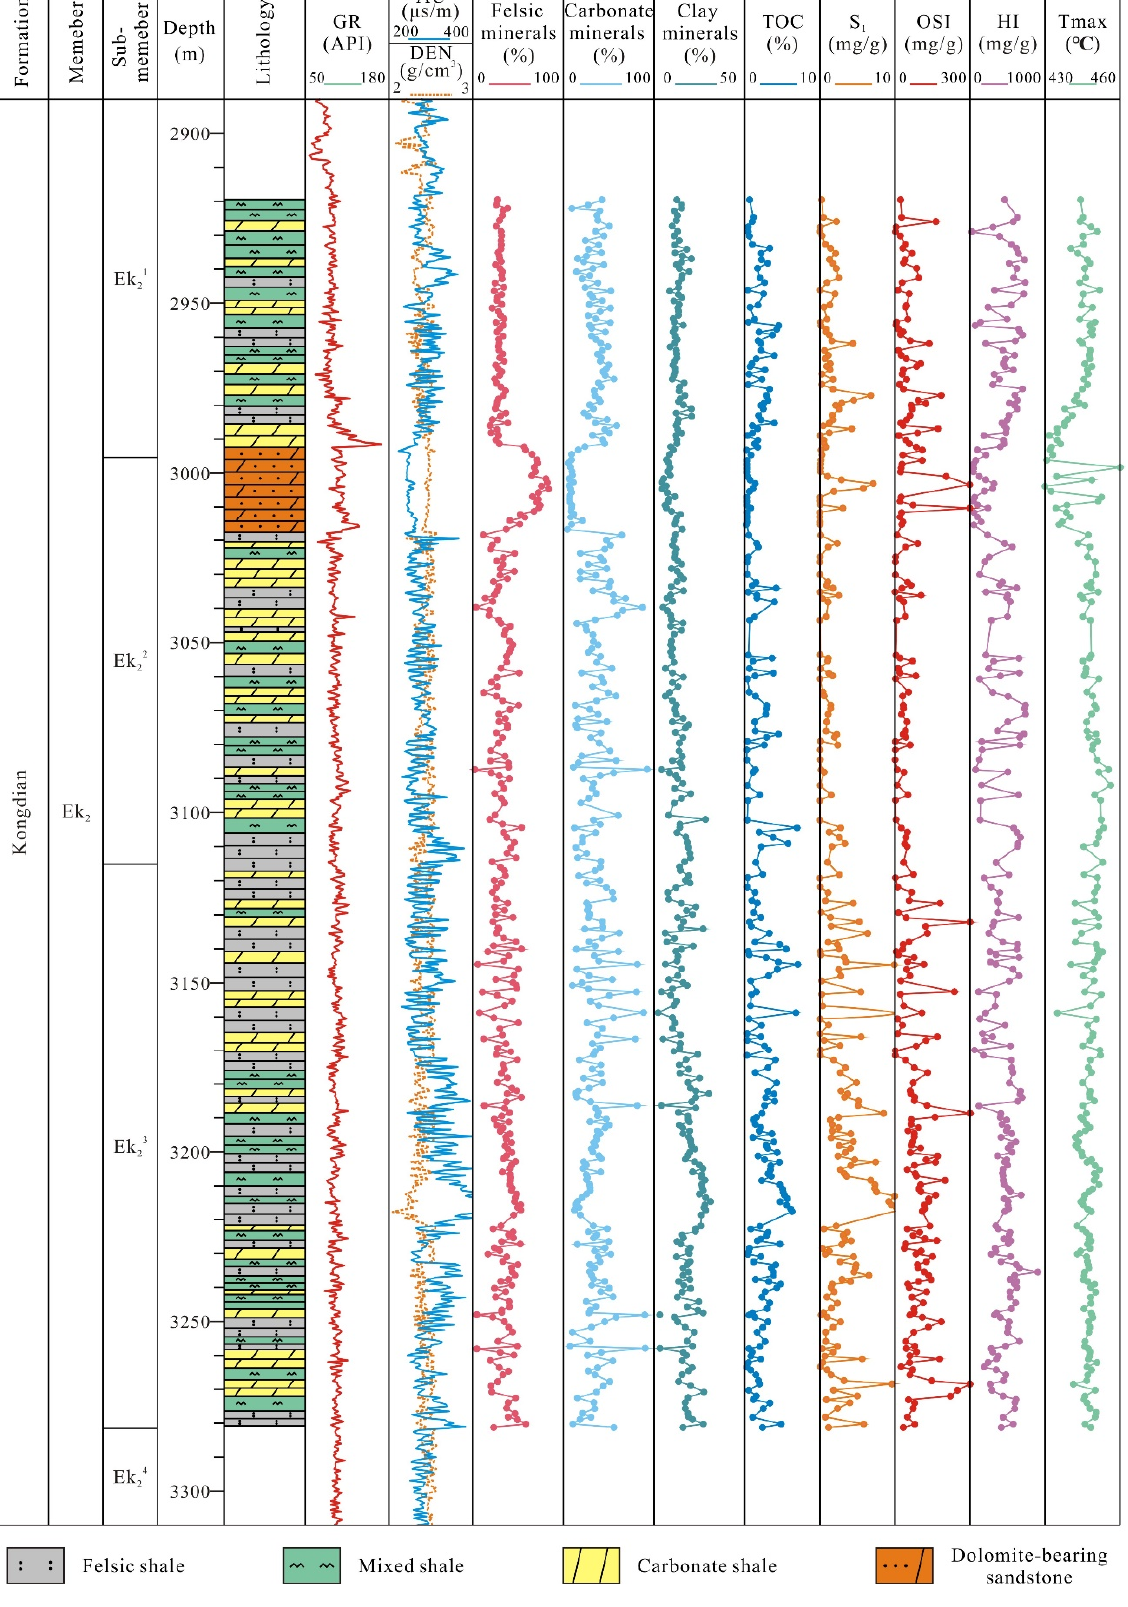
Figure 3. Mineral compositions and geochemical parameters of the Ek 2 shales in the Cangdong Sag.